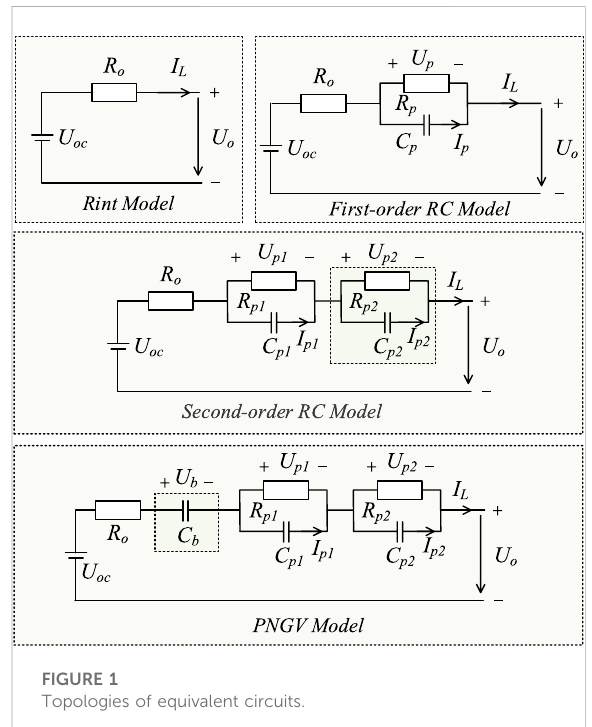
FIGURE 1 Topologies of equivalent